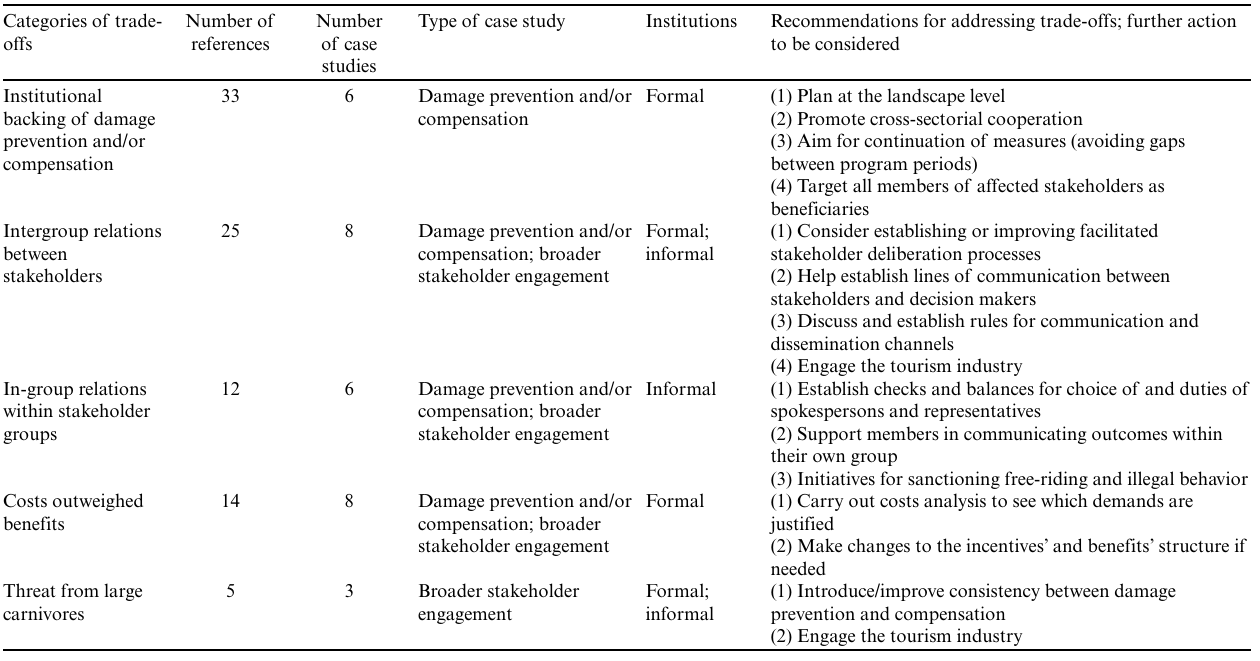
Table 3 . Characteristics of stakeholder input and further action to be considered for each category of